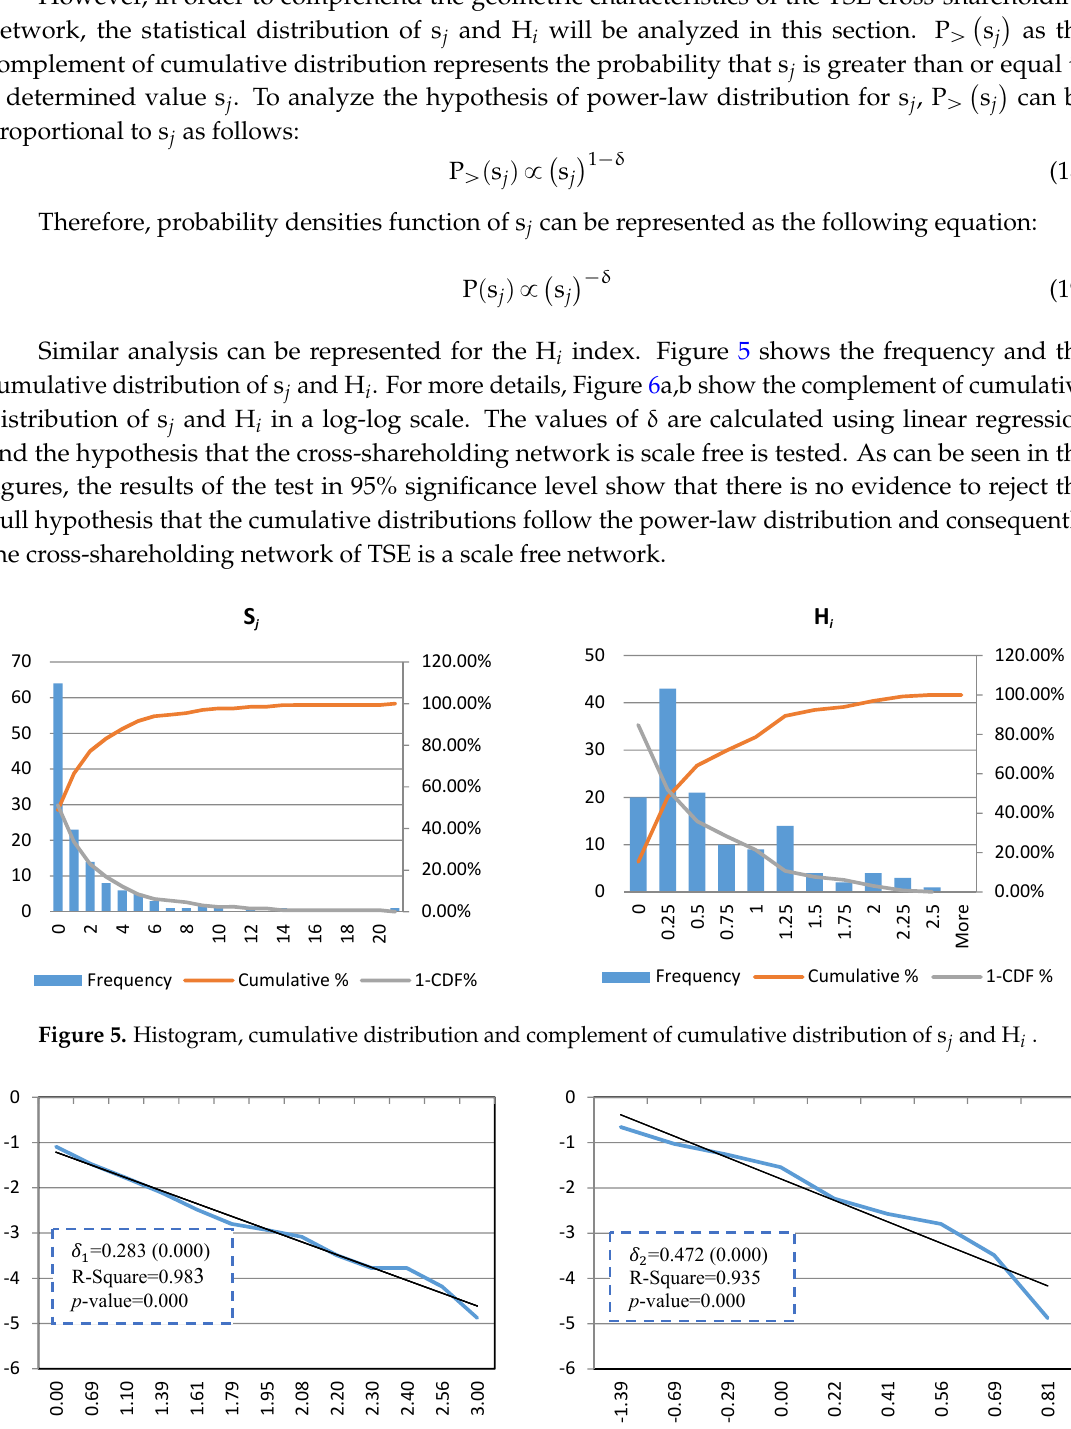
Figure 4. S (cid:3037) versus H (cid:3036) relationship.